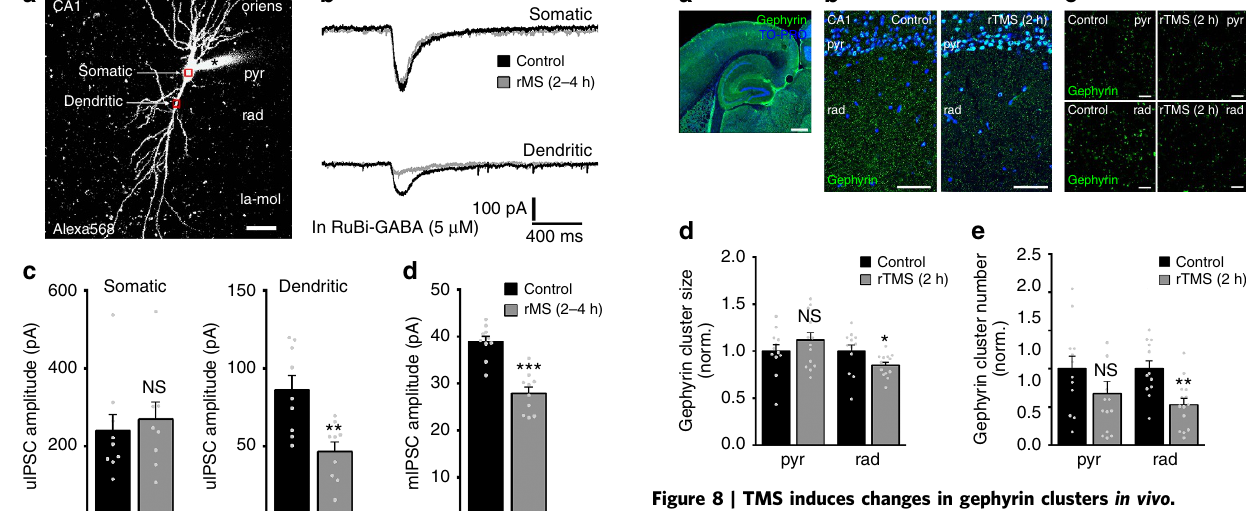
reactions are involved in rMS-induced remodelling of inhibitory postsynapses (see also refs 39,53,54). Hence, it is likely that rMS acts on inhibitory neurotransmission by modulating the Ca 2 þ /calcineurin-dependent gephyrin oligomerization/dissoci- ation rather than gephyrin synthesis/degradation; a suggestion that is also supported by our qPCR and western blot results on unaltered gephyrin mRNA and protein levels 3 h after rMS in vitro . Whether the rMS-induced destabilization of gephyrin scaffolds, the resemble distinct mechanisms that share overlapping signalling